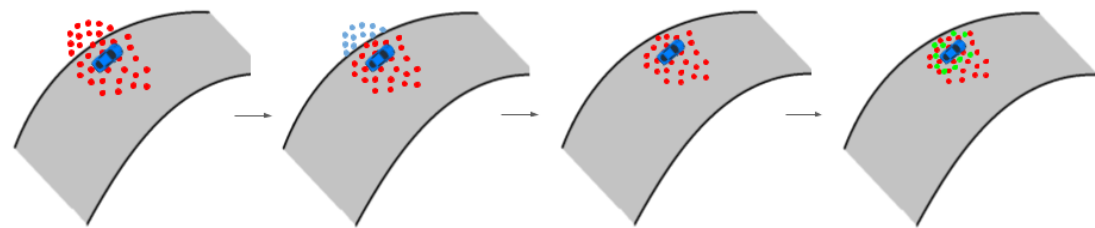
Figure 8. Illustrative schema of the IAMCL algorithm. The particles are first drawn with a distribution around an initial pose, then the ones with states that violate the track boundaries are eliminated and redrawn in the admissible state